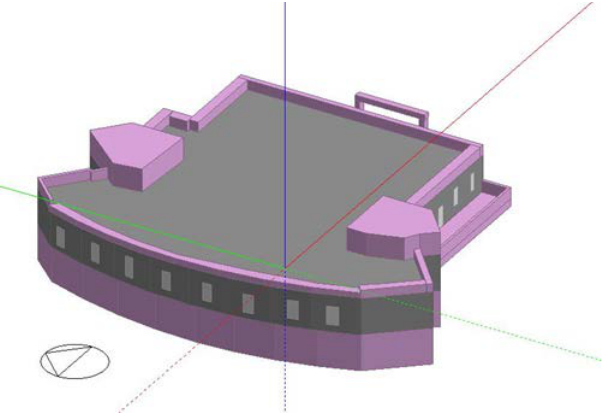
Figure 2. Calibrated building model. Table 1. Heat transfer coe ffi cient and thermal conductivity of the building